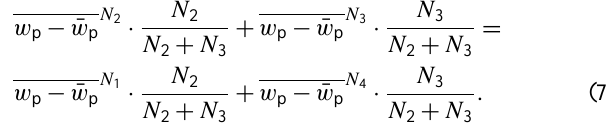
Figure 11. As Fig. 10, but for the water surface. The curves are the results predicted with the SS80 scheme by setting the laminar layer resistance 1/ w D to zero. The height of the measuring point is 25mm above the water